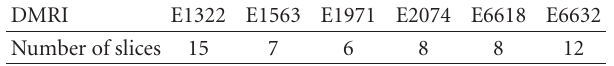
Table 1: The number of slices of each DMRI group.